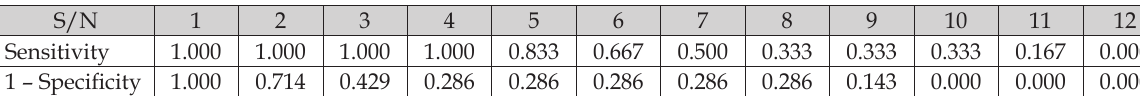
Table 3. Coordinates of the ROC